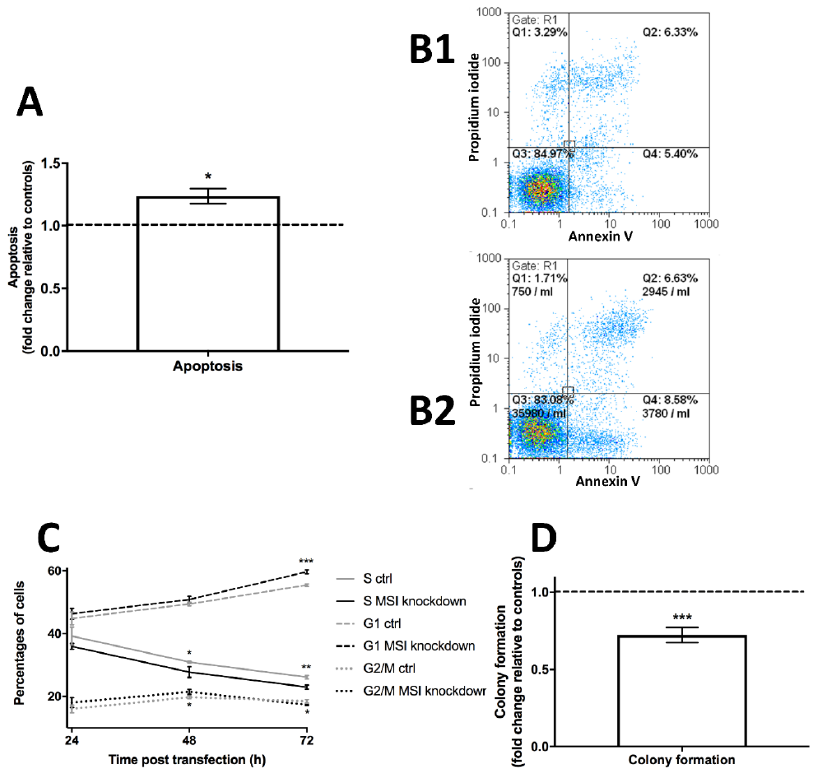
Figure 3. Influence of Musashi ( MSI ) RNA-binding protein knockdown on apoptosis, cell cycle progression and colony formation in triple-negative MDA-MB-231 cells. A : Apoptosis is upregulated after MSI knockdown compared to controls using Annexin V/propidium iodide flow cytometry assay, representative images for control cells in B1 and for MSI knockdown cells in B2 . Apoptotic cells are shown in Q4. C : Changes in cell cycle progression after MSI silencing as quantified by DNA staining followed by flow cytometry, compared to respective controls (ctrl). D : Colony formation is strongly downregulated after MSI knockdown. Cells were transfected with a control siRNA and MSI-1 and MSI-2 siRNA, respectively, as detailed in the Methods section (at least n = 3, * p <0.05, ** p < 0.01, *** p < 0.001, error bars indicate s.e.m.).